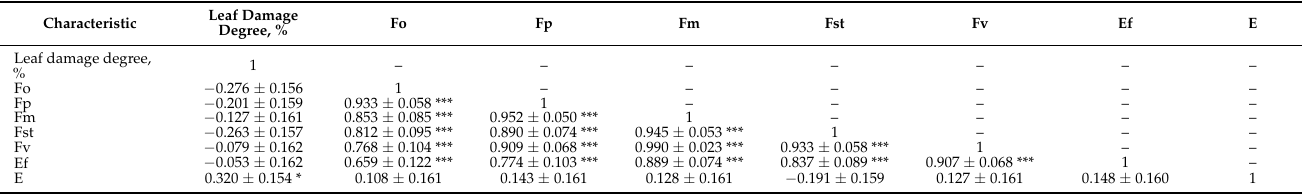
Table 4. Correlations between the Kautsky curve parameters and the degree of leaf damage by phytophages ( n =